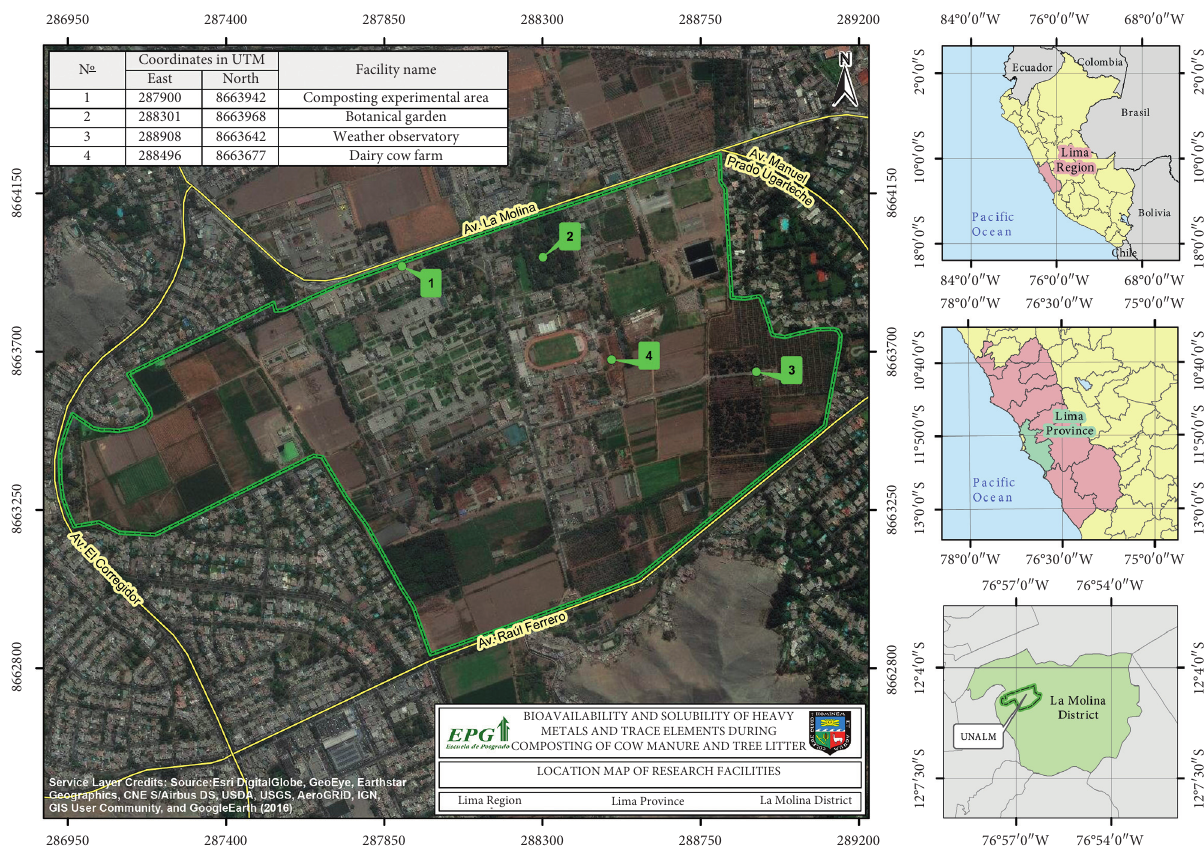
Figure 1: Satellite image of the university campus with the facilities which contributed to the investigation. Table 1: Raw materials for composting used in the investigation stages.